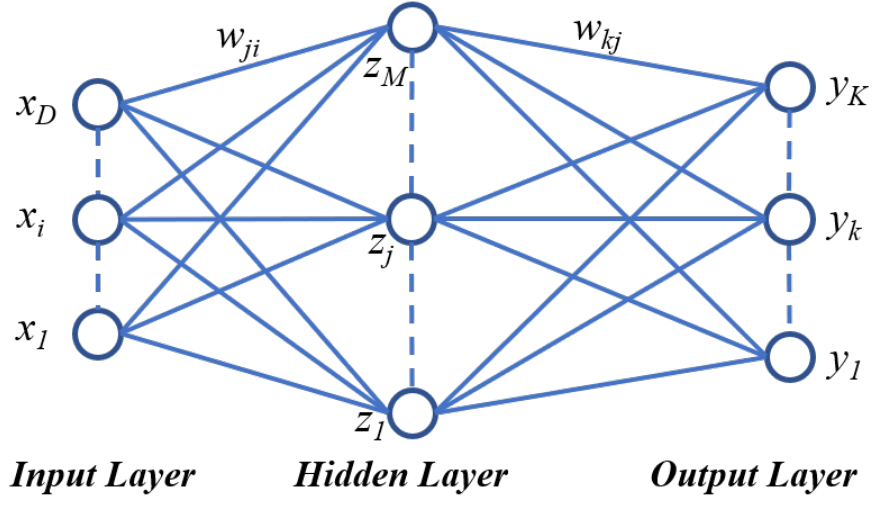
Figure 9. Structure of the NN diagram.